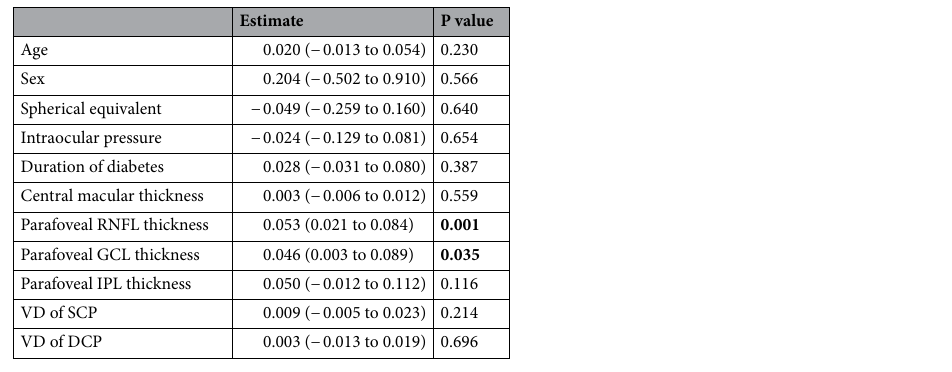
Table 4. Linear mixed models assessing the effects of putative factors predicting changes in best-corrected visual acuity over time. Values in boldface (P < 0.05) are statistically significant. RNFL retinal nerve fiber layer, GCL ganglion cell layer, IPL inner plexiform layer, VD vessel density, SCP superficial capillary plexus, DCP deep capillary